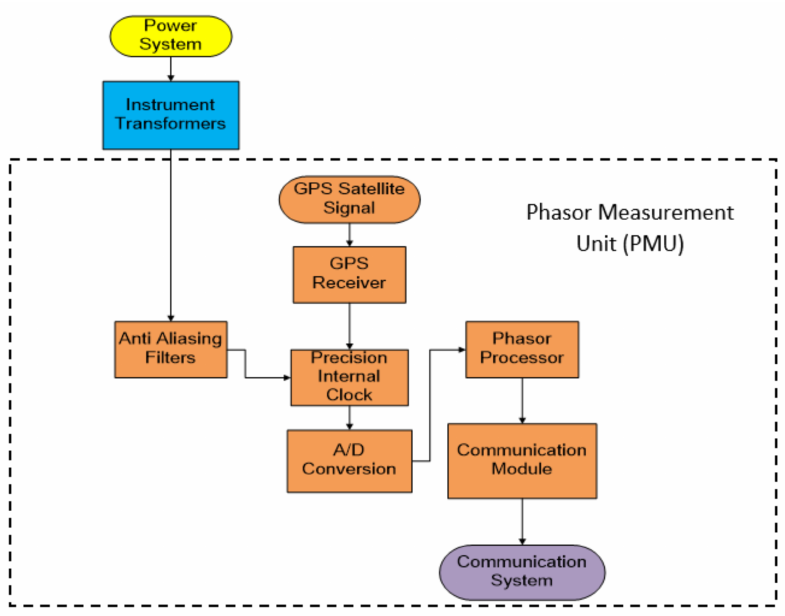
Figure 1. Basic structure of PMUs.